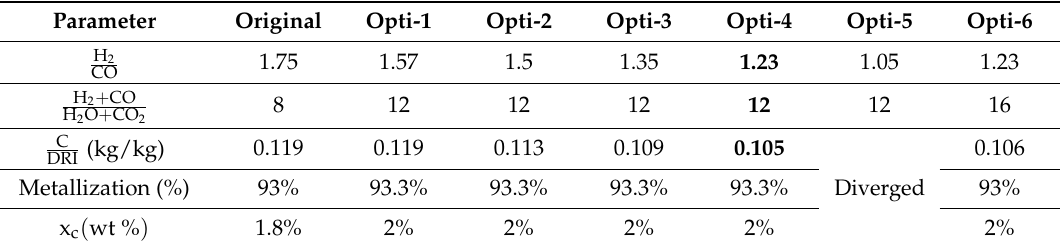
Table 5. Optimization runs in the Gilmore